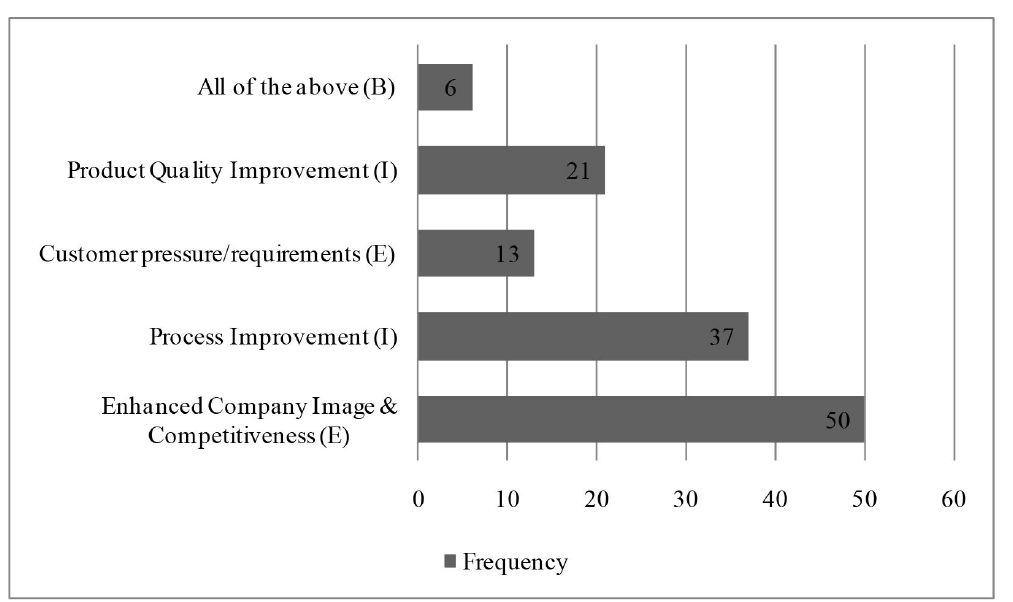
Figure 1. Motivational factors for ISO 9001